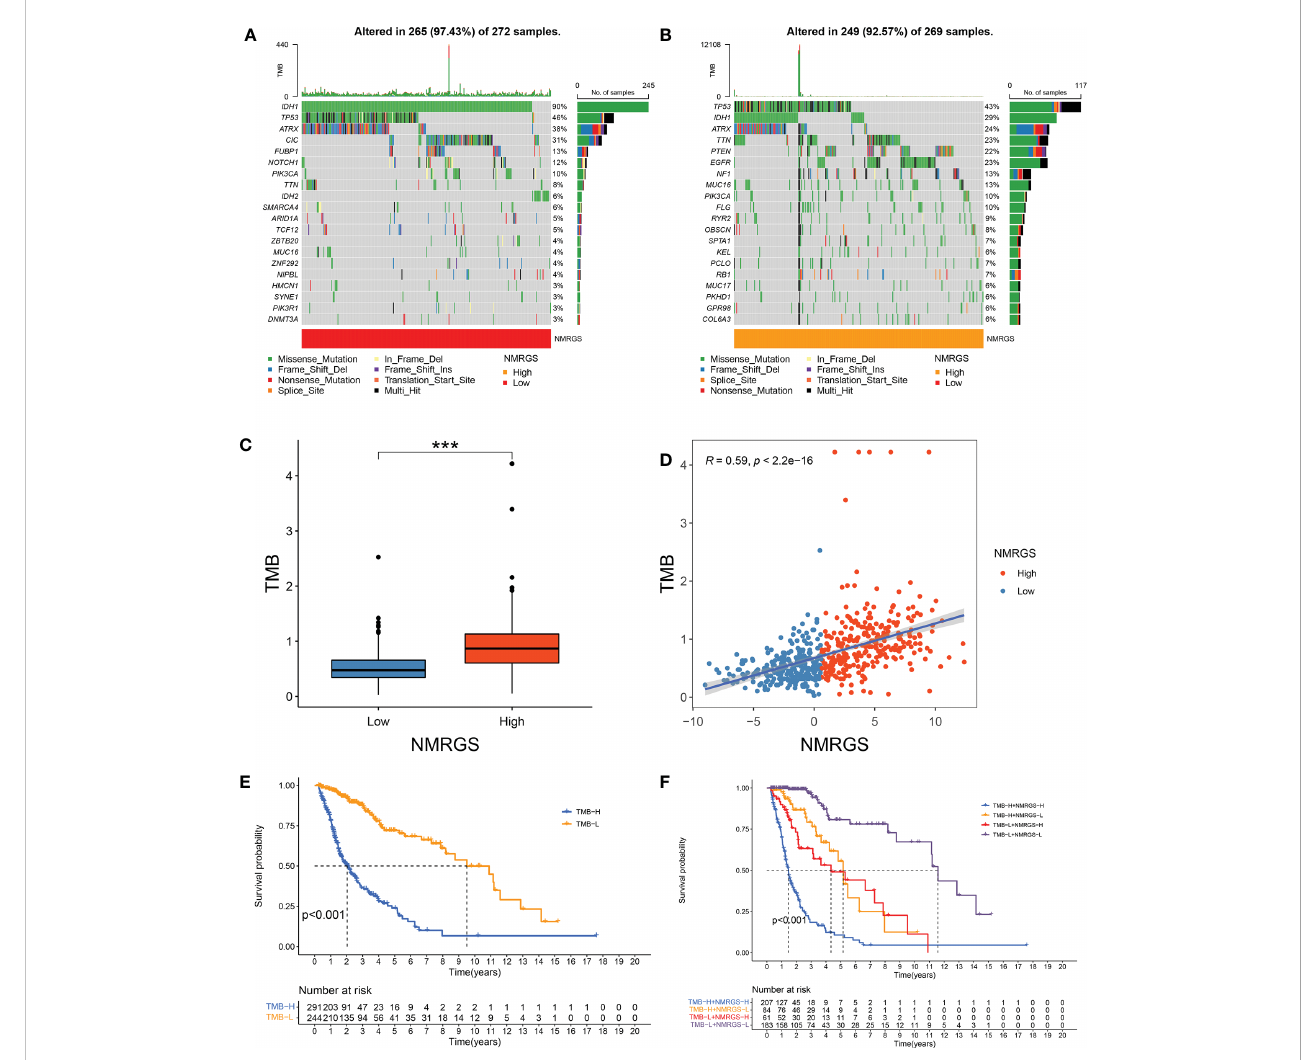
FIGURE 7 Association between NMRGS score and TMB. (A) Top 20 mutated genes in NMRGS-low group. (B) Top 20 mutated genes in NMRGS-high group. (C) Comparison of TMB between NMRGS-low group and NMRGS-high group. (D) The correlation between NMRGS score and TMB. (E) KM analysis between the high-TMB group and the low-TMB group. (F) Comprehensive KM analysis of the effects of NMRGS and TMB on survival. ***p <